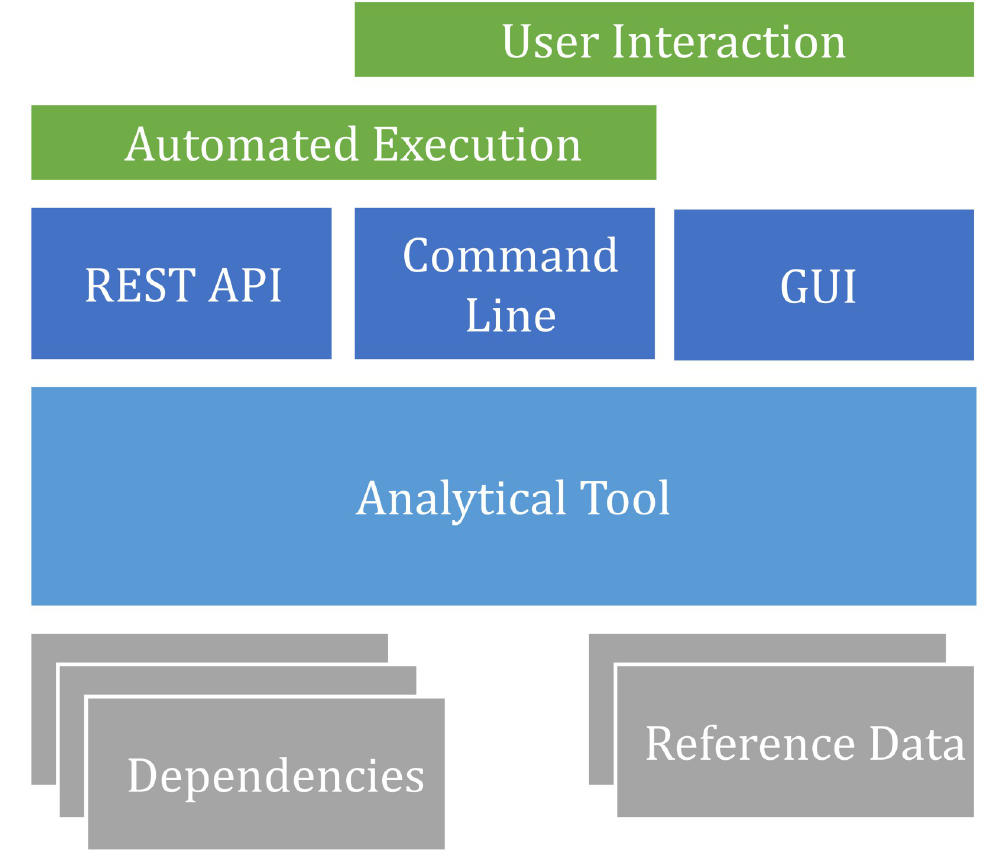
Fig 1. An analytical tool can be adapted for both automated execution and user interaction by refactoring the graphical and command line interfaces as separate modules that use the analytical algorithms as a common library. Such separation can also support a REST API, which can be used for both automation and interactive web